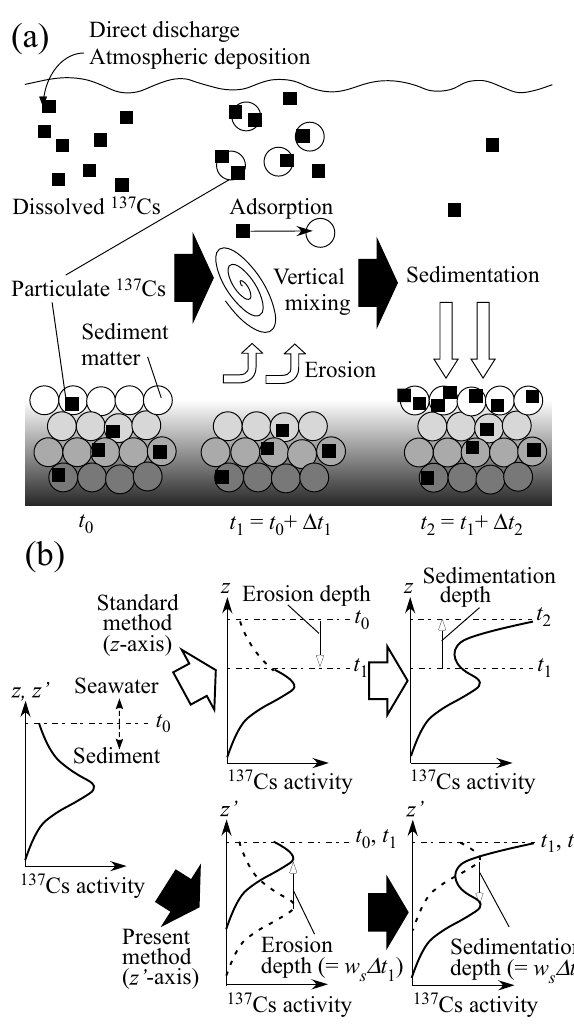
Figure 1. Schematic views of (a) processes of 137 Cs migration from seawater to sediment and (b) numerical procedure of vertical 137 Cs transport in sediment using z (cid:48) coordinate defined in Sect.